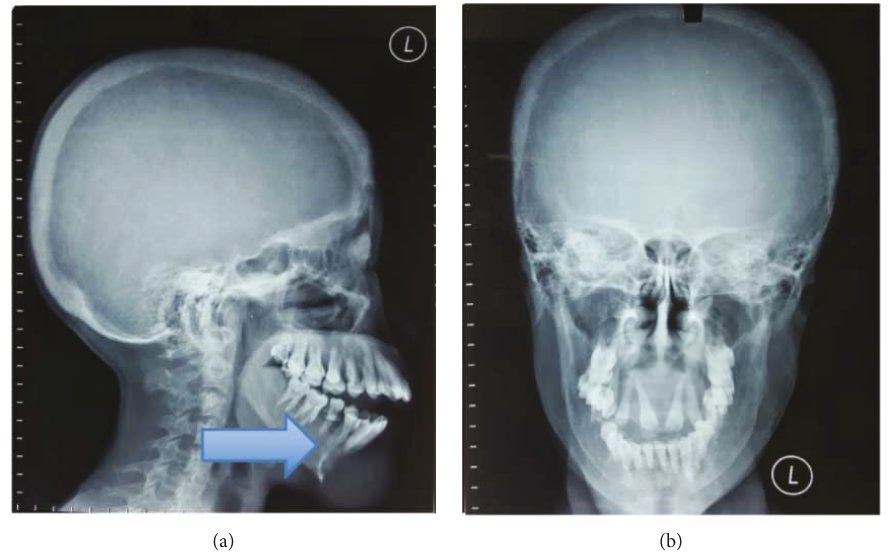
Figure 2: Case 1. (a) Bone survey radiographic examination of the cranium. (b) Multiple lytic lesion with well-de fi ned border in the cranium. Arrow shows bone resorption activity in lower alveolar area.